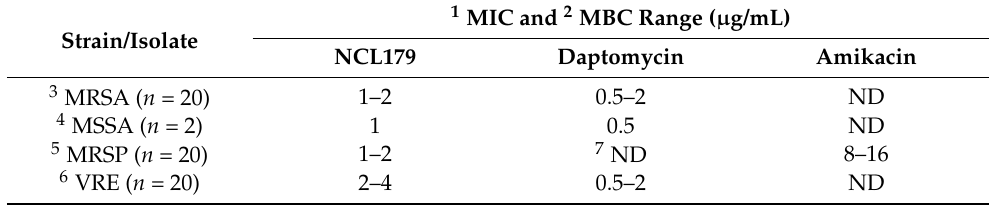
Table 1. In vitro activity of NCL179 against Gram-positive ATCC strains and clinical isolates.